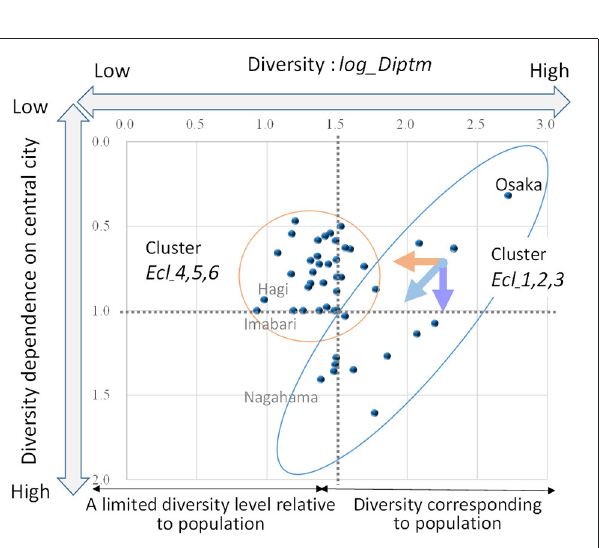
FIGURE 10 | Relationship between Diptm of central cities and diversity dependence on central